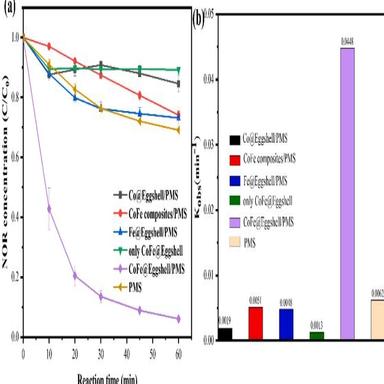
The NOR degradation efficiency of various systems (a) and the rate constants of NOR degradation in various systems (b). (General condition: = 10 mg/ L, PMS = 0.4 g/L, catalyst = 0.3 g/L, without adjusting the initial pH, T = 25±0.1◦C. The error bars represent results of three duplicates.).